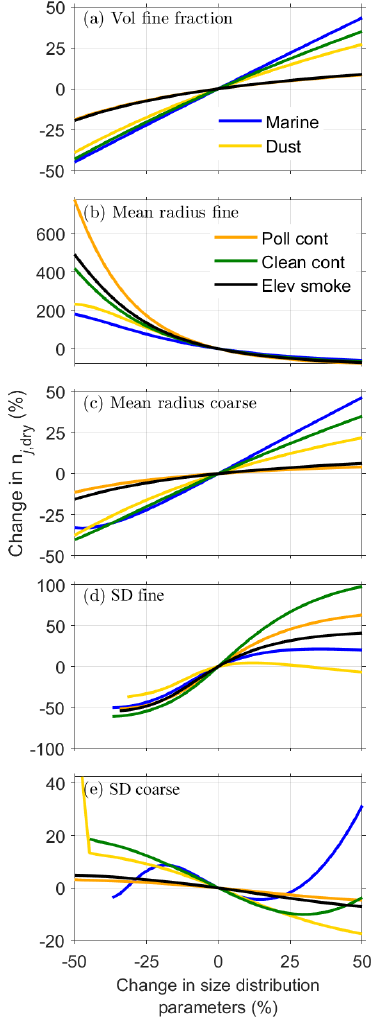
Figure 2. Sensitivity of n j, dry ( j = 100 for dust and 50 for other aerosol subtypes) to the size distribution parameters: volume fine fraction (a) , mean radius fine (b) , mean radius coarse (c) , standard deviation fine (d) , and standard deviation coarse (e) . The x axis rep- resents perturbations in the size distribution parameters in percent- age of their original values taken from the CALIPSO aerosol model. The y axis represents the corresponding percentage change in n j, dry relative to that estimated from the unperturbed size